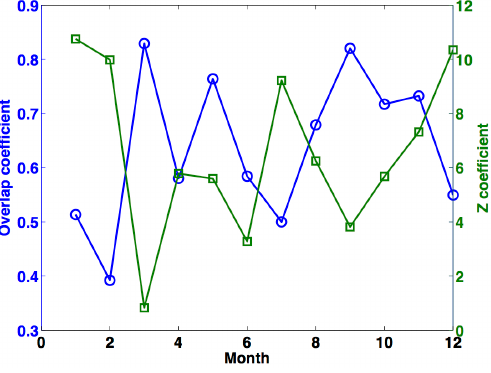
Fig. 9. Monthly overlap coefficient (OVL) and Z